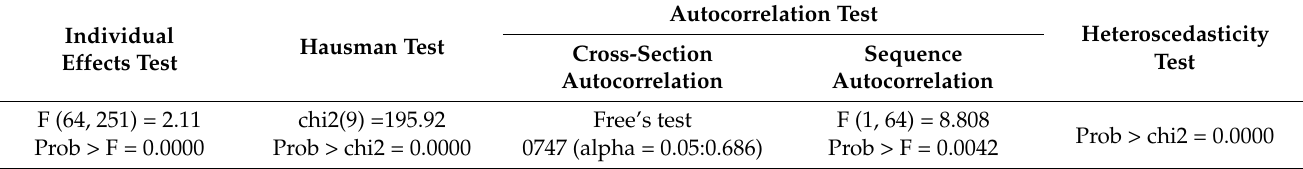
Table 9. Model test